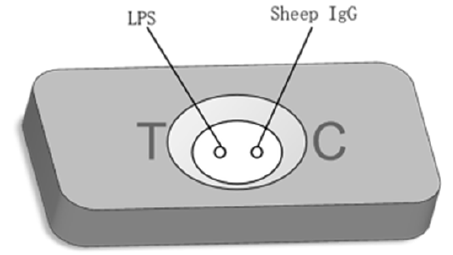
Figure 2. T-point and C-point coating diagram.